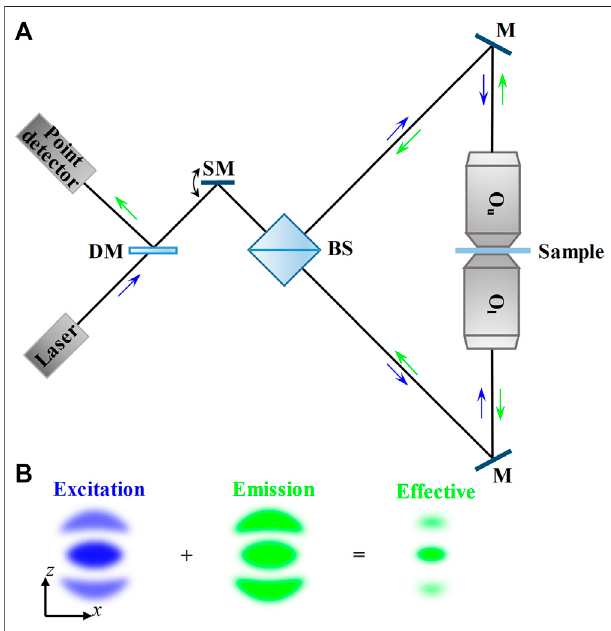
FIGURE 2 | Schematic and principle of 4Pi-type – C microscopy. (A) Schematic of 4Pi-type – C microscopy. The excitation beam from the laser is fed through a scanning mirror and a 50/50 beam splitter into the 4Pi cavity. The fl uorescence emitted from the sample is inversely collected by the same objective lenses and re fl ected by a dichroic mirror, and fi nally collected by a point detector. (B) PSFs in 4Pi-type – C microscopy in the axial (xz) plane. The effective PSF is obtained by the superimposition of excitation PSF and emission PSF. Blue and green arrows indicate the directions of the excitation beam and fl uorescence. DM, dichroic mirror; SM, scanning mirror; BS, 50/50 beam splitter; M, mirror; Ou, the upper objective lens; O l , the lower objective